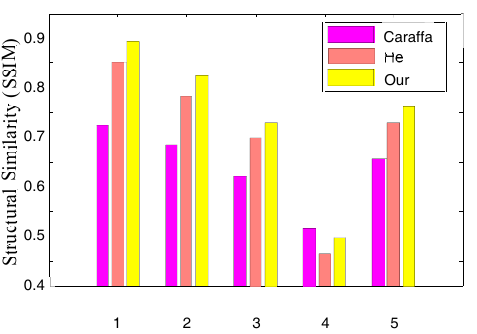
Figure 12. Structural Similarity Index of different algorithms. Structural Similarity Index Measurement (SSIM) of different algorithms.